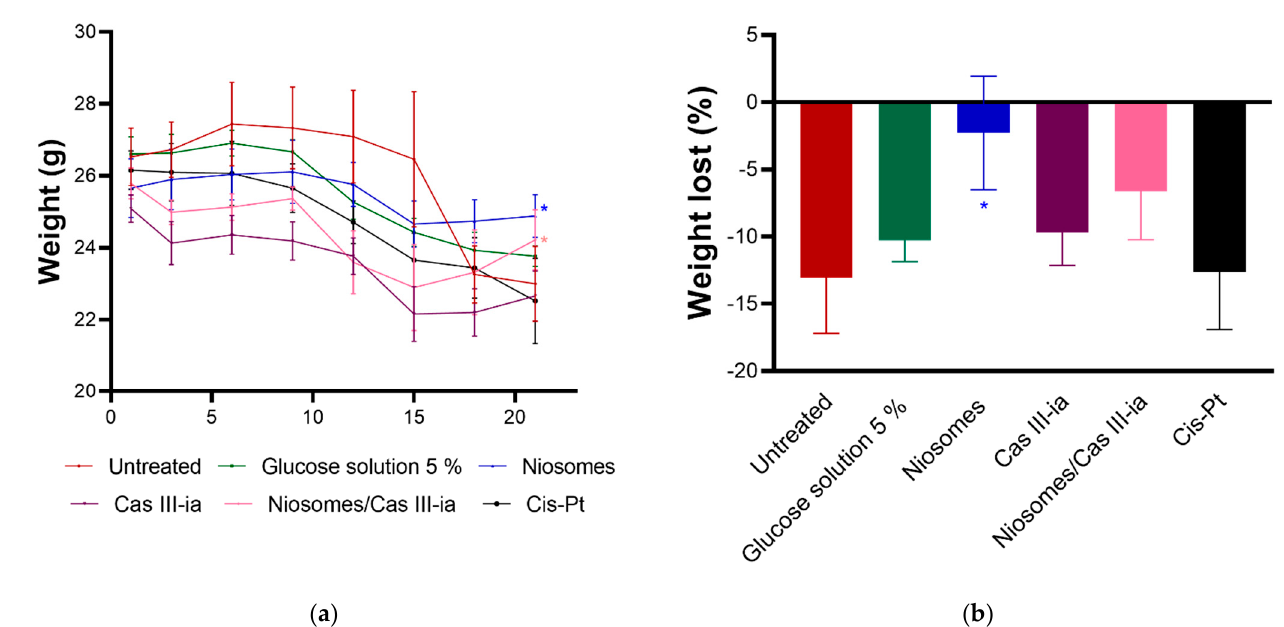
Figure 10. ( a ) The initial and final weight of BALB/c mice before, during, and after treatment. ( b ) Toxicity was measured by the percentage of weight loss of mice. The percent weight loss, as an indicator of toxicity, was calculated for each animal as follows: [(weight at day 21/weight at day 0) − 1] × 1000. The unpaired t-test was used to evaluate statistical significance among groups (marked with an asterisk).